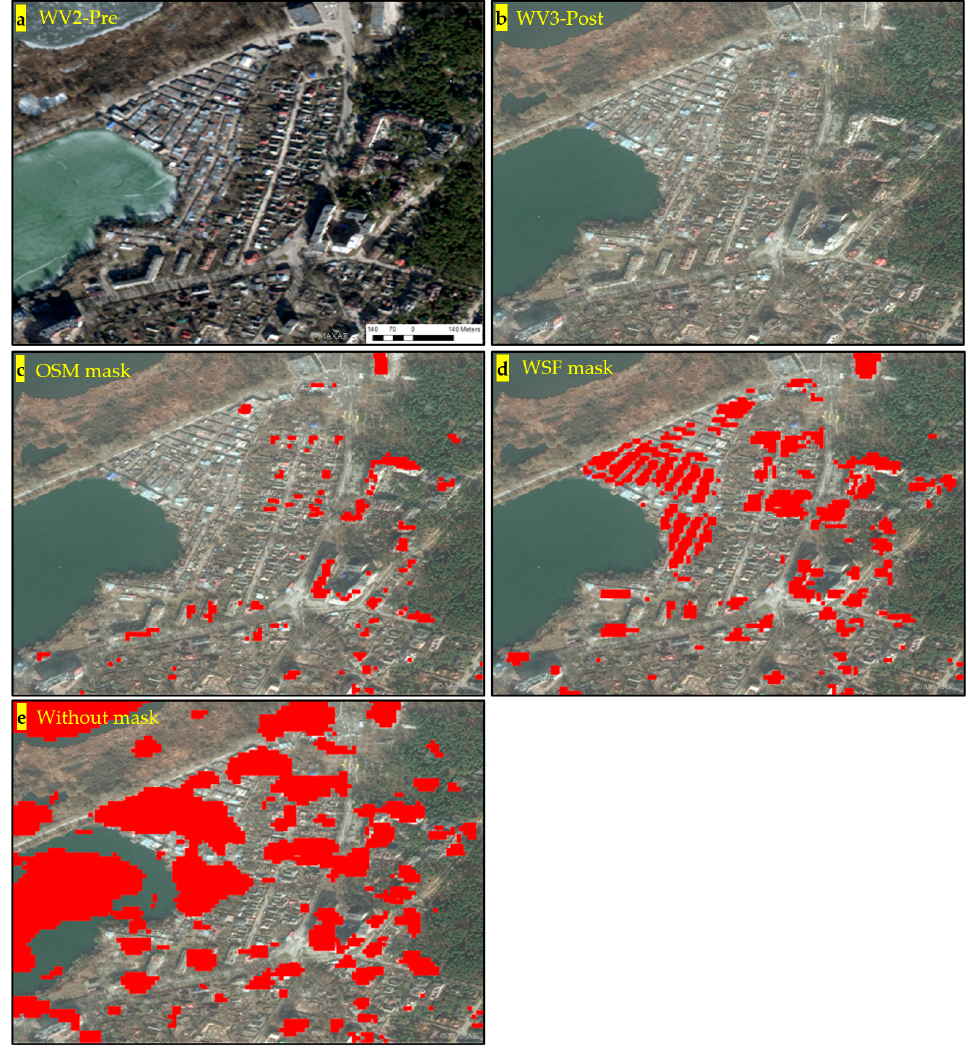
Figure 11. WSF VS OSM building footprint mask on the SAR intensity results. ( a , b ) are pre- and post-event WorldView images taken on 28 February 2022 and 31 March 2022; ( c – e ) are the results after applying OSM and WSF building mask, and without mask.